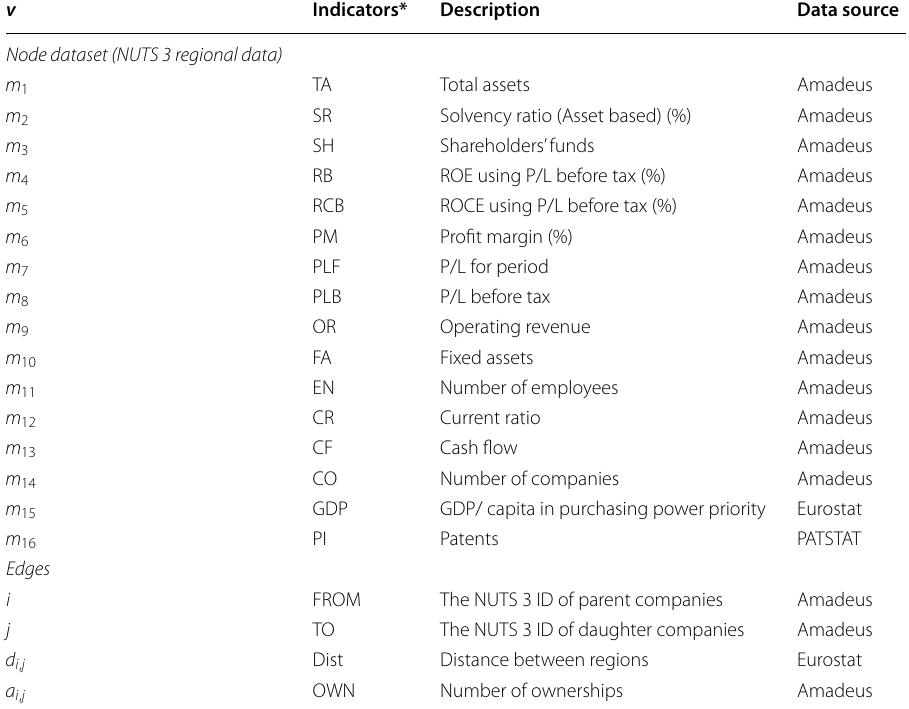
Table 1 Applied